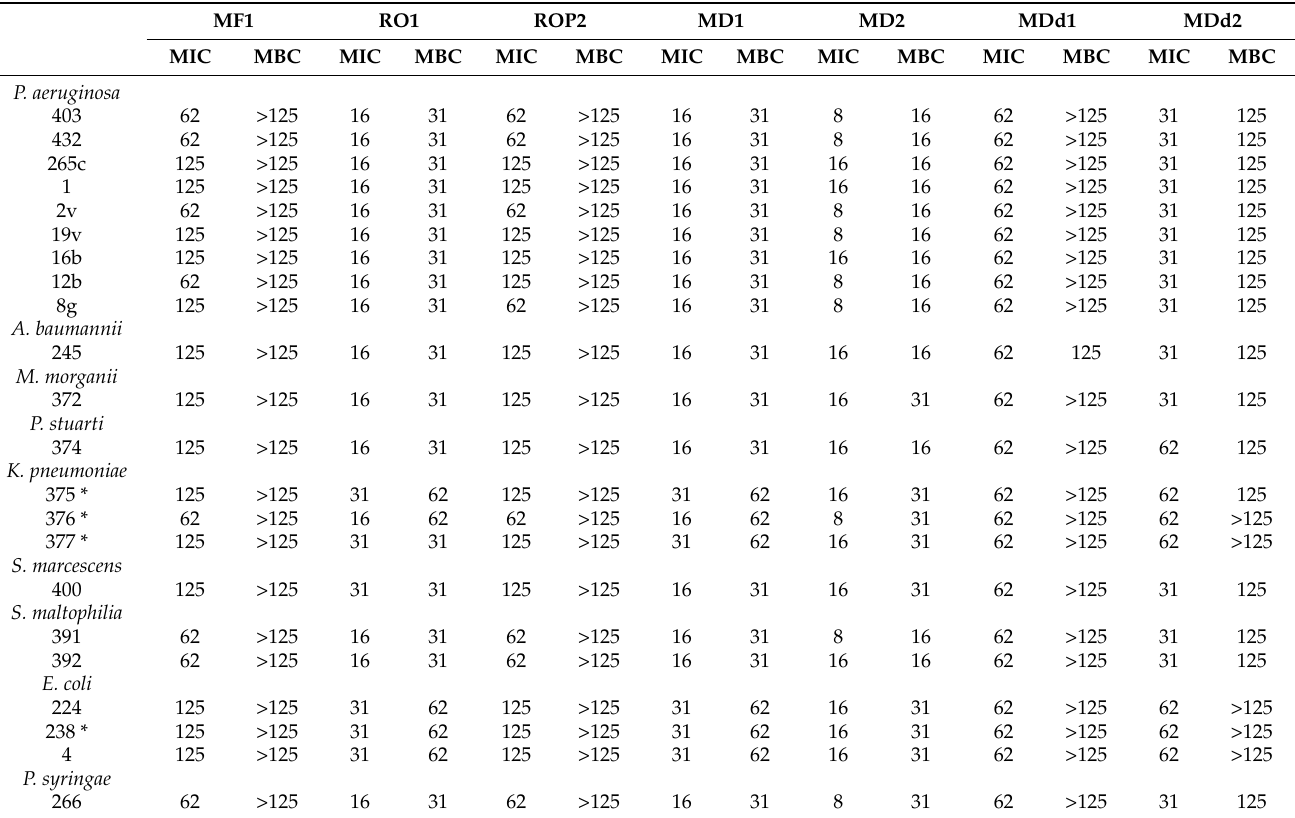
Table 5. MIC and MBC values expressed as mg/mL of the seven OMW samples on the selected Gram-negative strains. Experiments were carried out in triplicate. The degree of concordance in all the experiments was 3/3. Variation among triplicate samples was less than 10%. C denotes resistance to colistin; * denotes a class A carbapenemase (KPC)-producing